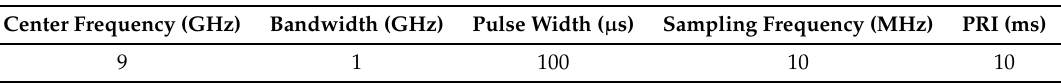
Table 3. Simulation parameters of the comparison with the adjacent cross-correlation function (ACCF) method.